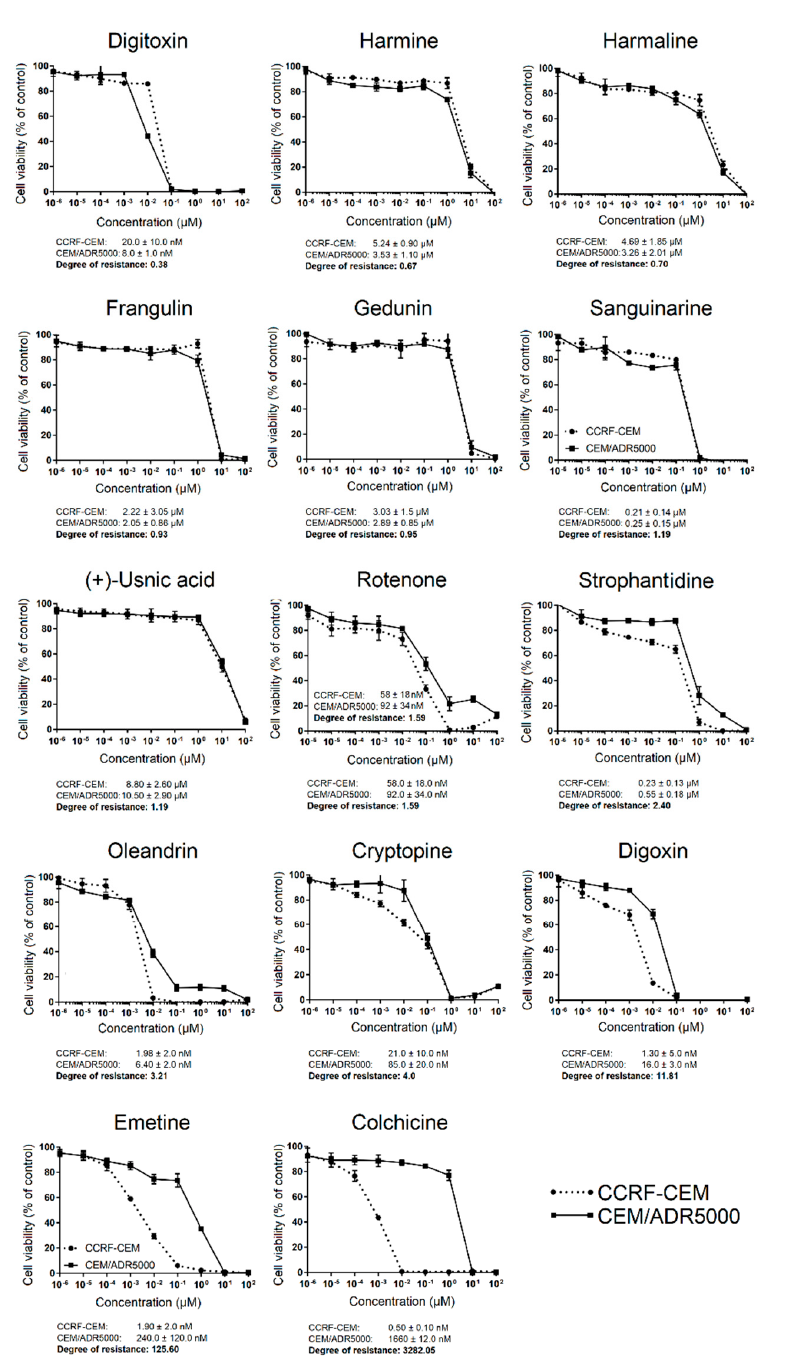
Figure 2. Dose-response curves of 14 selected phytochemicals in drug-sensitive parental CCRF- CEM and multidrug-resistant CEM/ADR5000 cells using the resazurin assay. The IC 50 values were determined from the dose-response curves, and the degrees of resistance were obtained by dividing the IC 50 of CEM/ADR5000 cells by the corresponding IC 50 value of CCRF-CEM cells. Shown here are the mean values ± SD of three independent experiments.